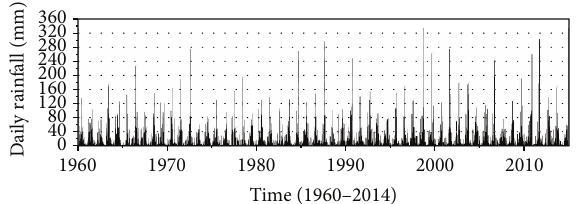
Figure 2: Daily rainfall data collected at the Seoul weather station,